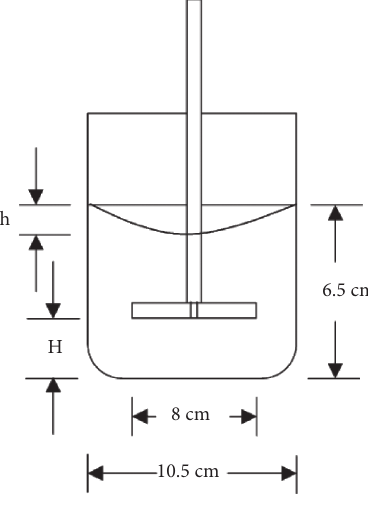
Figure 2: Crucible sketch [8].